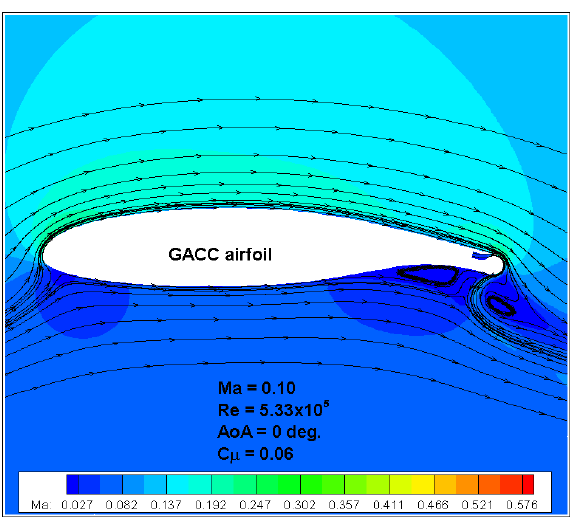
Figure 7. Flow field with streamlines and Mach contour.